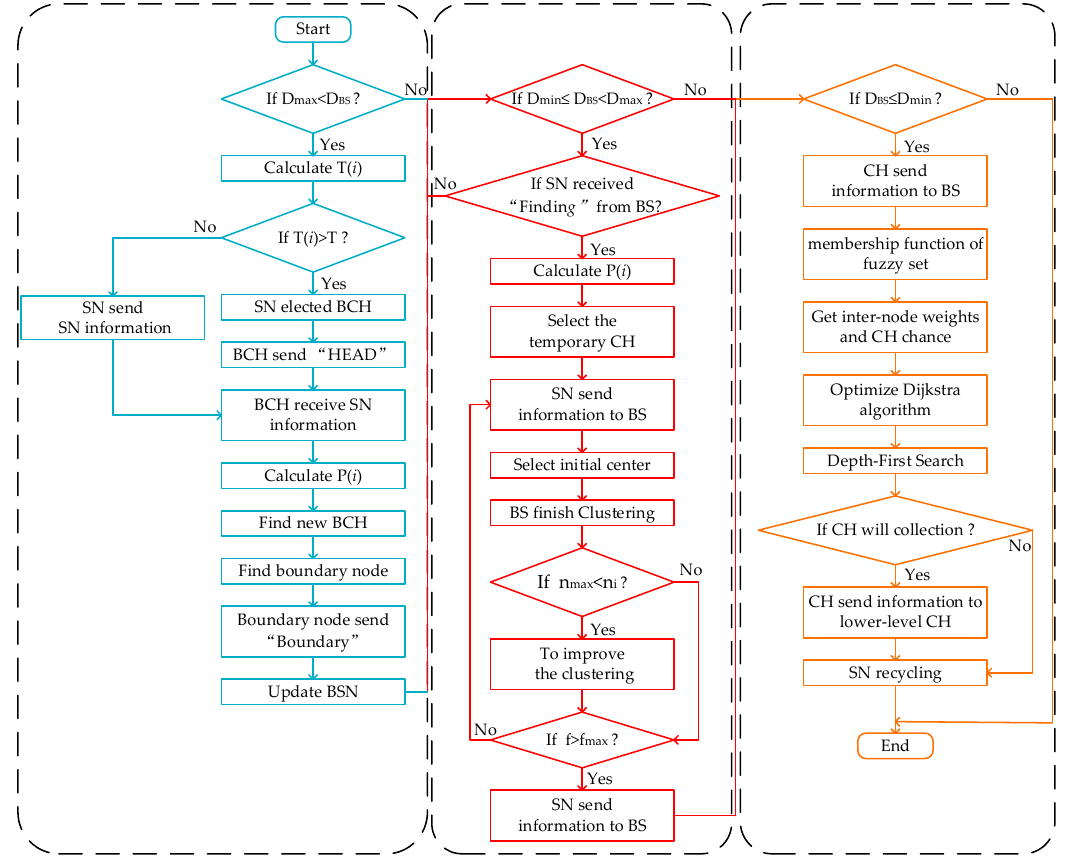
Figure 4. KFNS algorithm flow chart.